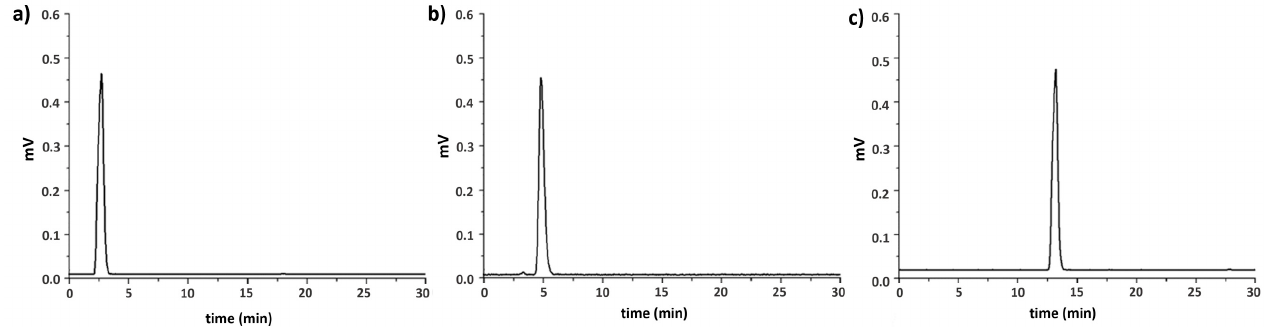
− , ( b ) fac -[ 99m Tc(CO) + , and ( c ) 99m Tc − 4 3 (H 2 O) 3 ]